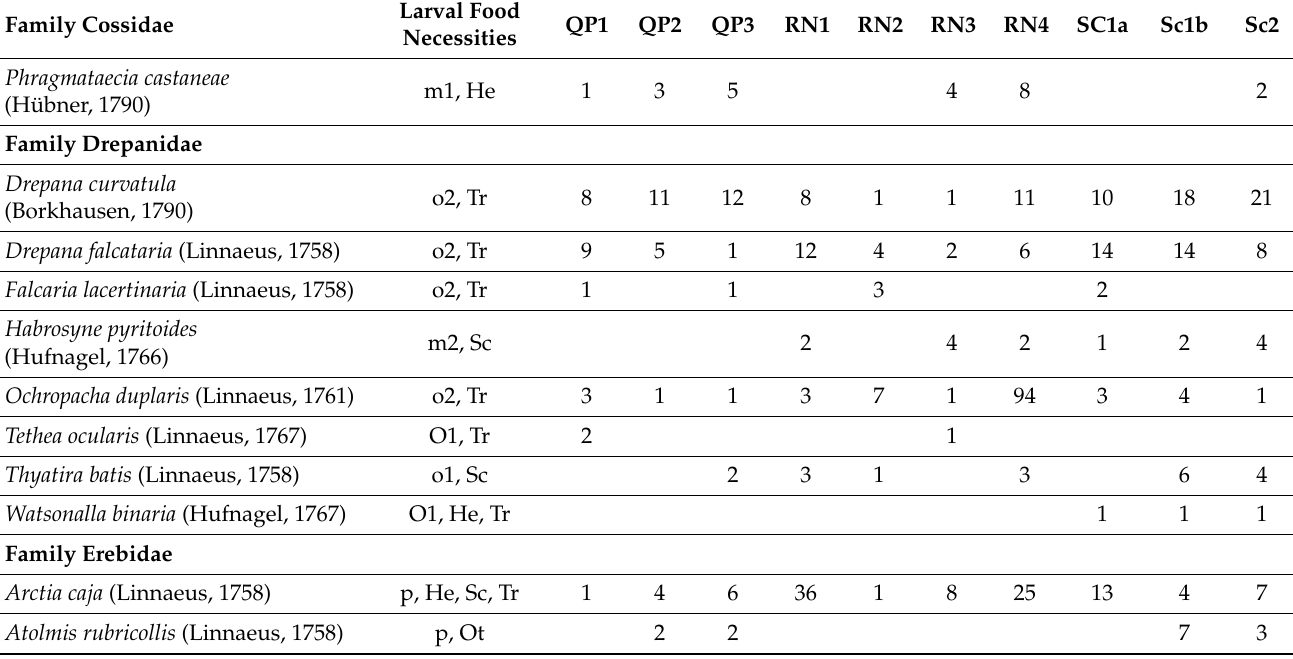
Table A1. List of species and individuals recorded in each site (see text for details).